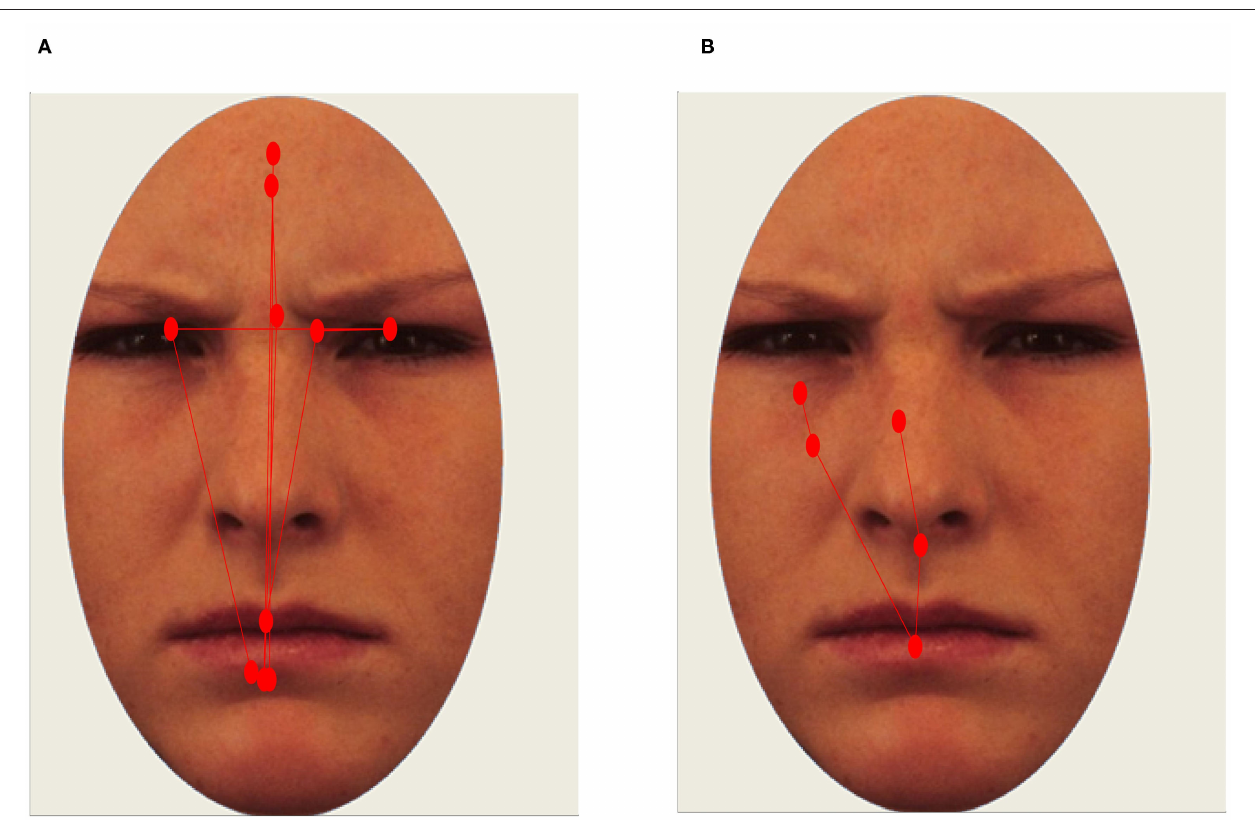
FIGURE 2 | Example of a long scanpath [ (A) ; scanpath length and RMS values above 75th percentile. Healthy participant] and restricted scanpath [ (B) ; scanpath length and RMS values below 25th percentile. Participant with SAD]. Red circles represent fixations.